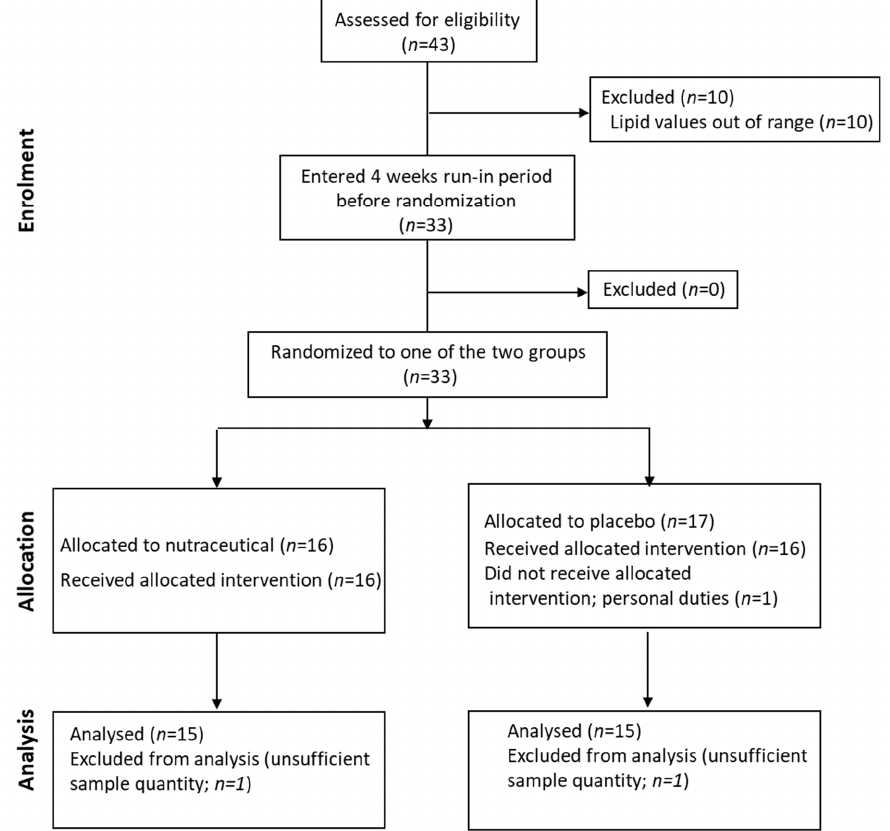
Figure 1. CONSORT statement flow diagram.